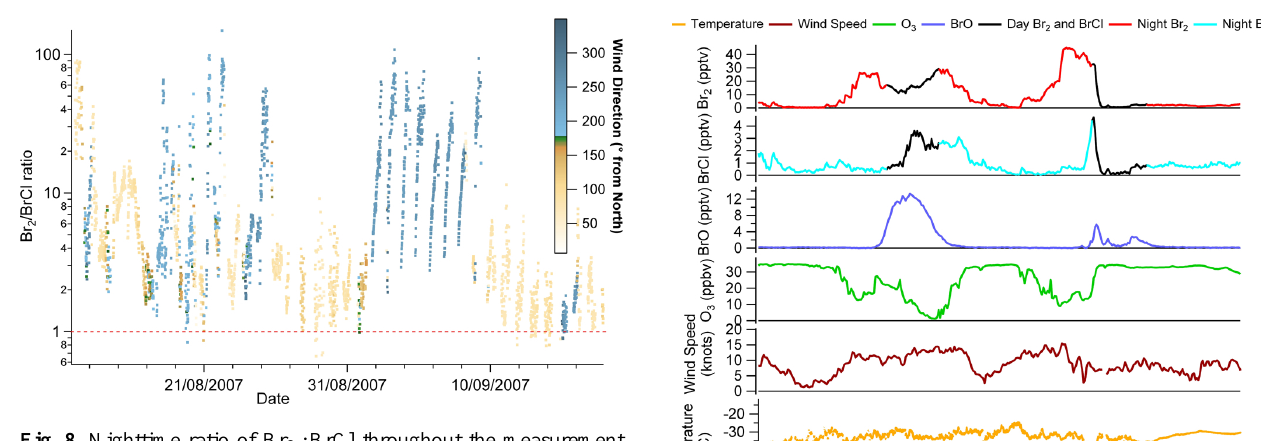
Fig. 8. Nighttime ratio of Br 2 :BrCl throughout the measurement period on a log scale. The colour coding indicates local wind direc- tion (blues indicate sea ice zone origin; oranges indicate continental origin), emphasising the influence of air mass origin on the calcu- lated ratio. A red dashed line is drawn at a ratio of one to highlight the small number of values found below it.